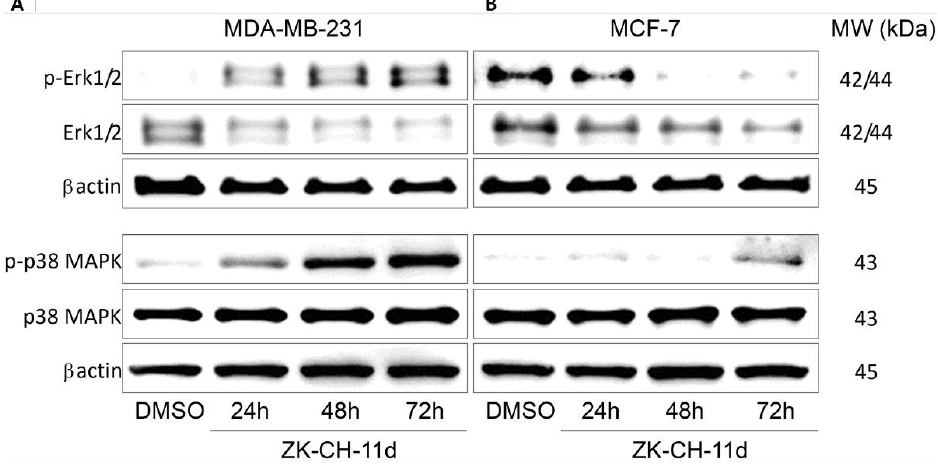
Figure 14. Analysis of Erk1/2 and p38 MAPK signaling pathways after treatment with ZK-CH-11d in MDA-MB-231 ( A ) and MCF-7 ( B ) cells.